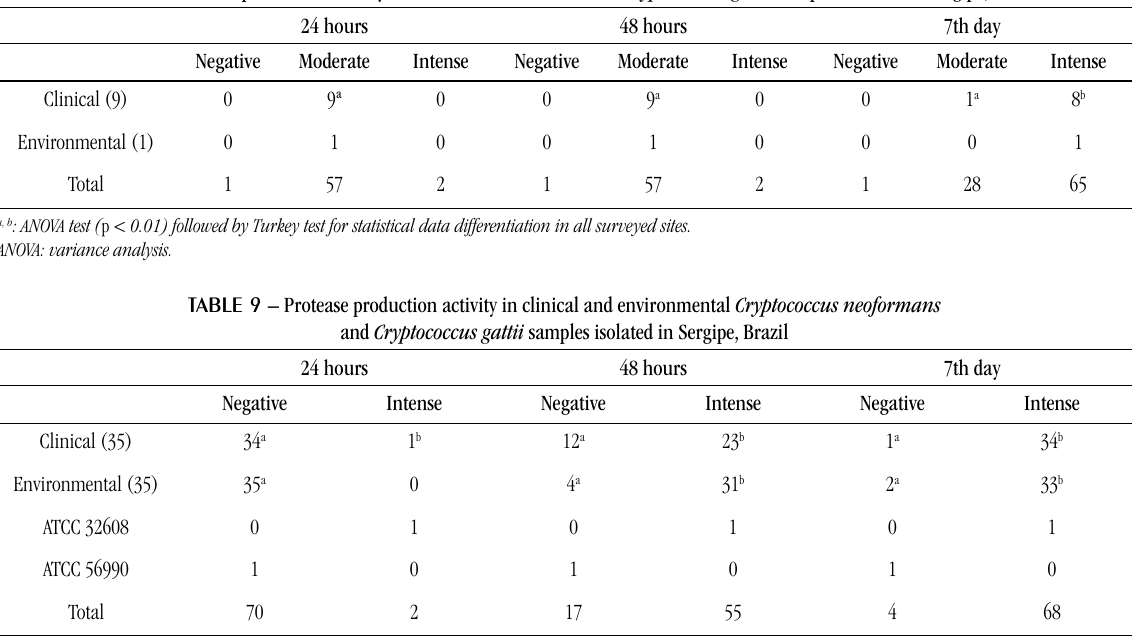
tABLE 8 – Urease production activity in clinical and environmental Cryptococcus gattii samples isolated in Sergipe, Brazil